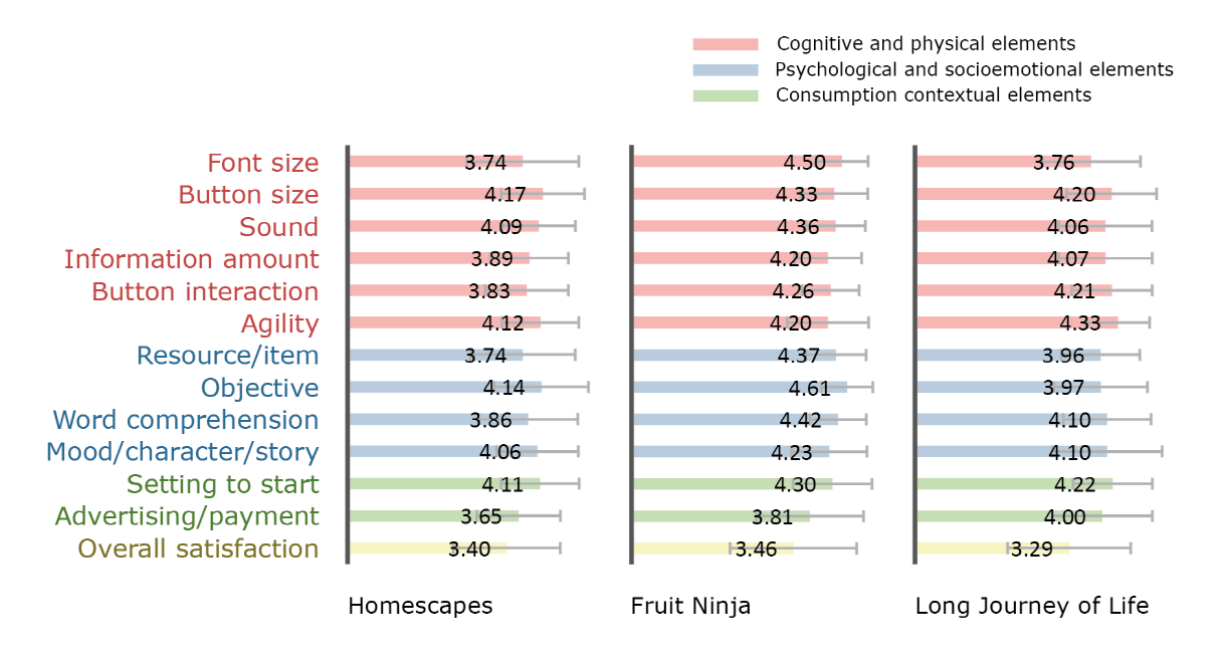
Figure 2. Satisfaction levels in games played by both